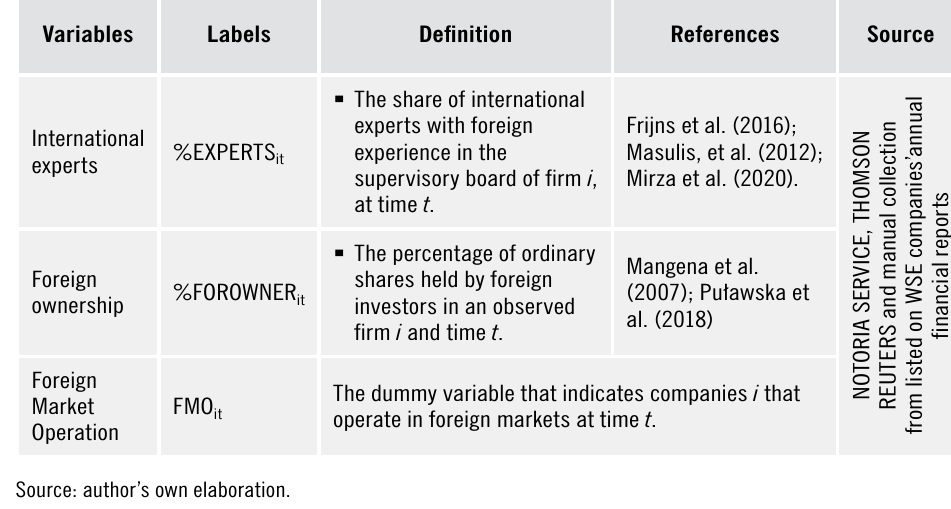
Table 2. Explanatory